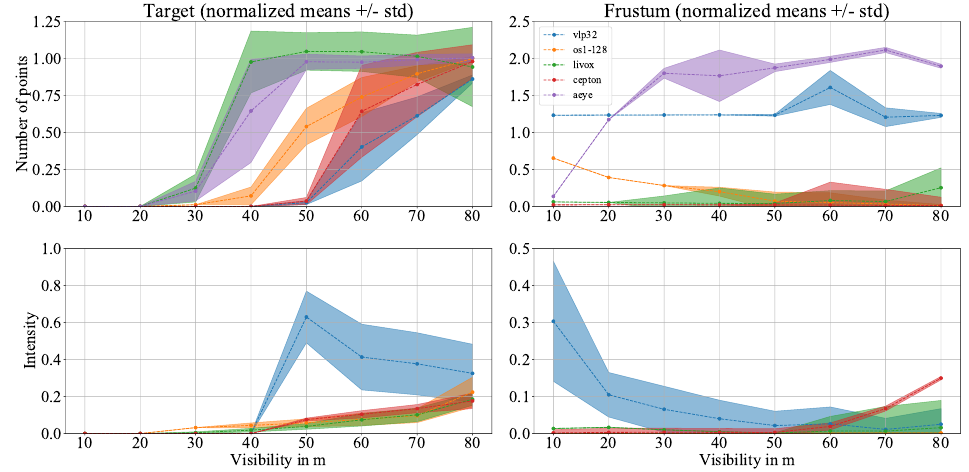
Figure 13. Sensors behaviors under foggy